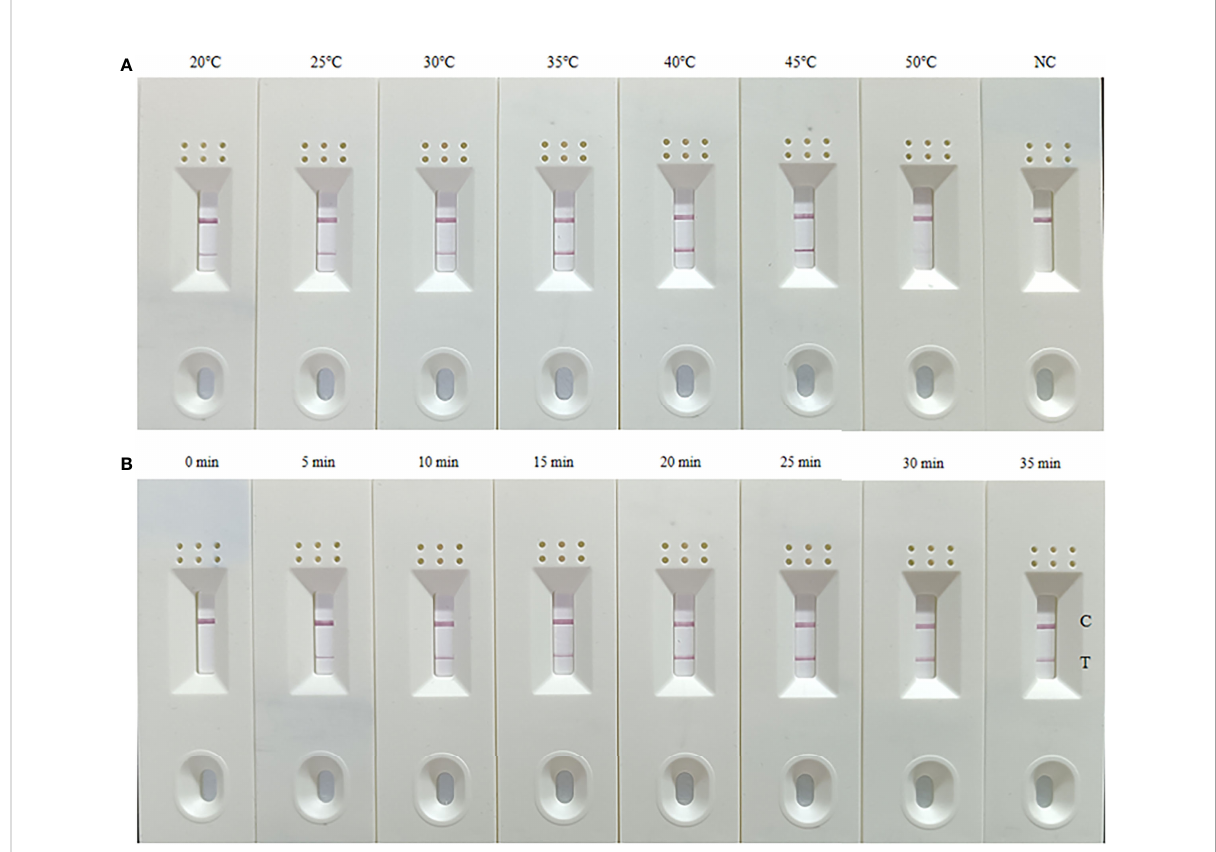
FIGURE 1 Optimization of the temperature (A) and time (B) for the MIRA-LFD assay. (A) The optimal ampli fi cation reaction time was determined by